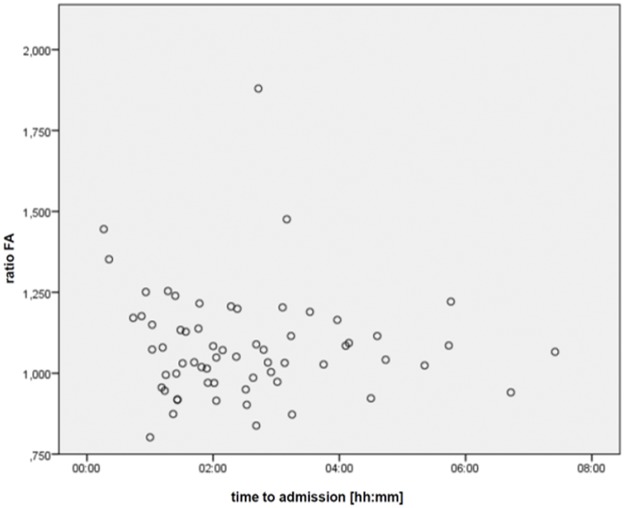
Ratio of FA versus time to MRI.The ratio of FA is plotted against the time to MRI.